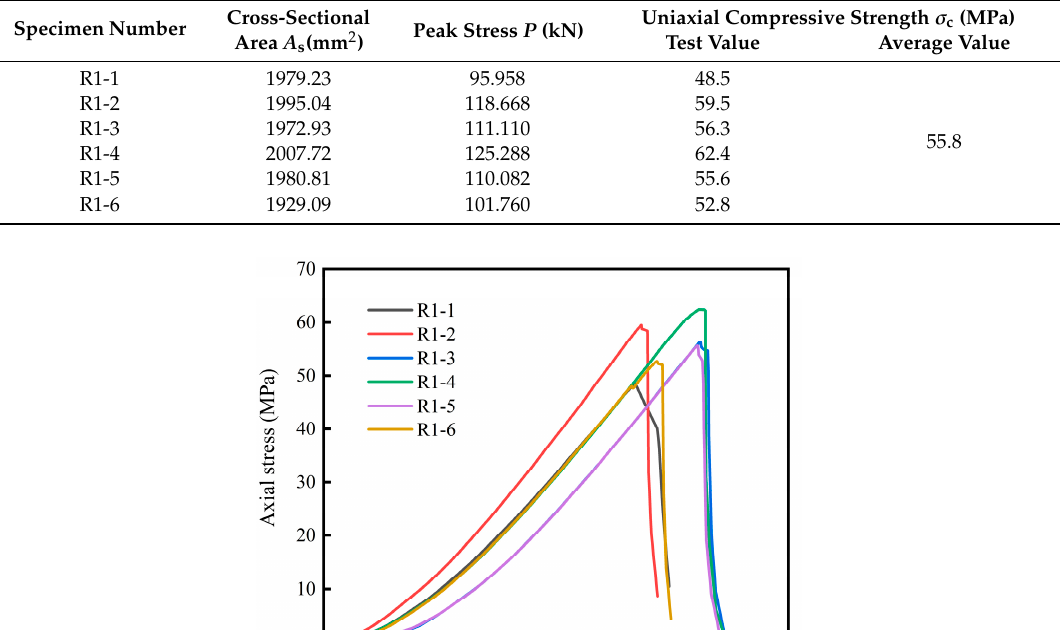
Table 3. Record table of uniaxial compressive strength (UCS) test.